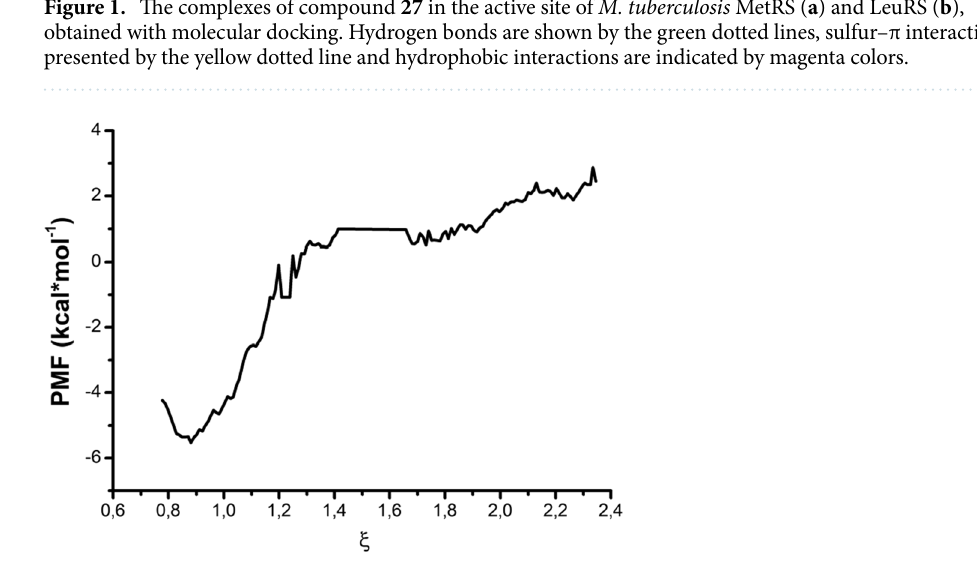
Figure 2. Potential of Mean Force (PMF) for unbinding of the complex of M. tuberculosis MetRS with compound 27